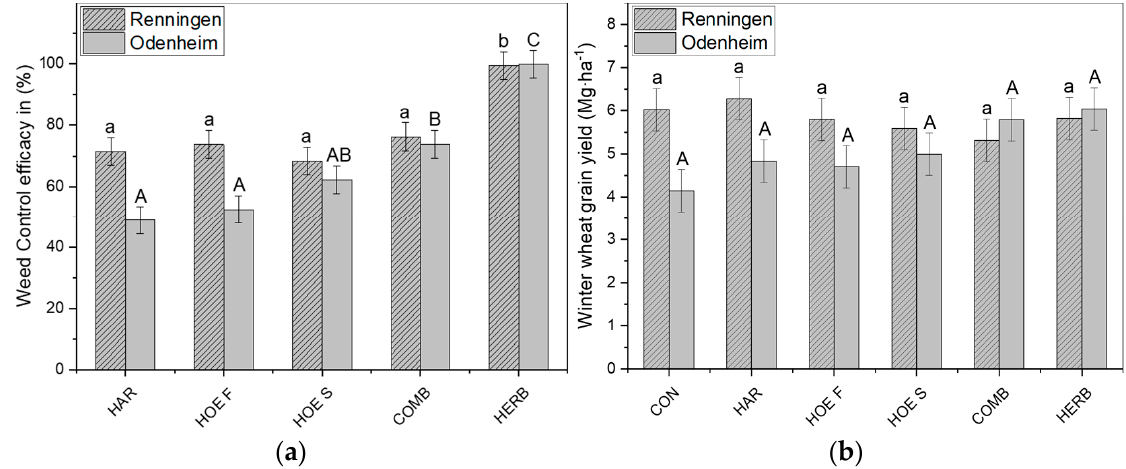
Figure 4. ( a ) Mean weed control efficacy in winter wheat three days after treatment; ( b ) winter wheat grain yield recorded in Renningen 2018 and Odenheim 2019. Variants with the same capital and small letter are not significantly different according to Tukey Honest Significant Difference test (HSD) at α ≤ 0.05. CON = untreated control, HERB = herbicide application, HAR = harrow, HOE S = hoe slow at 3 km ∙ h − 1 in Renningen 2018 and at 4 km ∙ h − 1 in Odenheim 2019, HOE F = hoe fast at 6 km ∙ h − 1 in Renningen 2018 and at 8 km ∙ h − 1 in Odenheim 2019, COMB = combination of harrow and hoe.